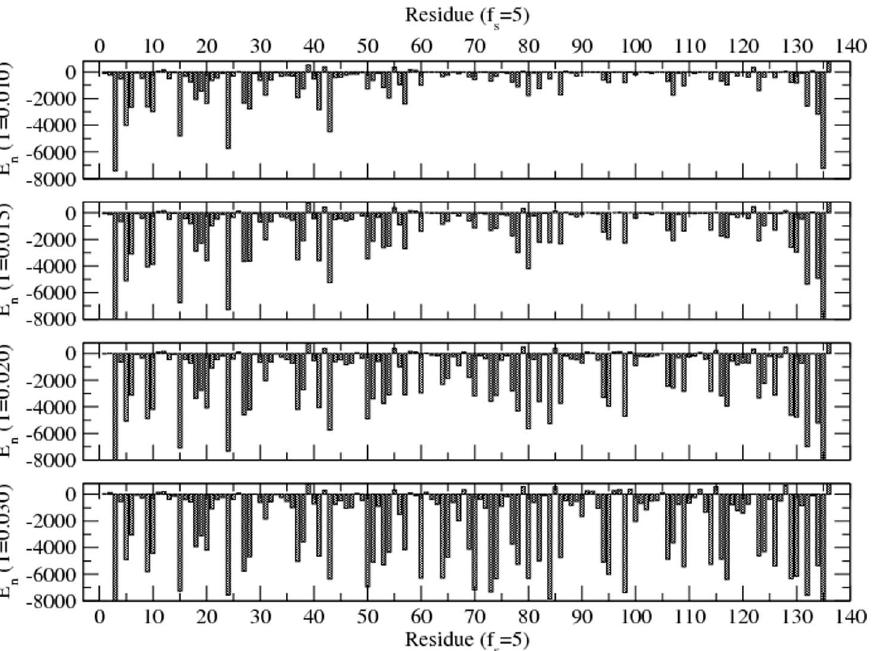
Figure 3. Average mobility (fraction of successful moves per unit time step) of each residue (of H3.1 protein) immersed in a solvent with the interaction strength f s =5 at temperatures T=0.010–0.030 (corresponding to figure 2). Simulations are performed on a 64 3 lattice for 10 7 time steps with 100 independent samples at each temperature and solvent strength.